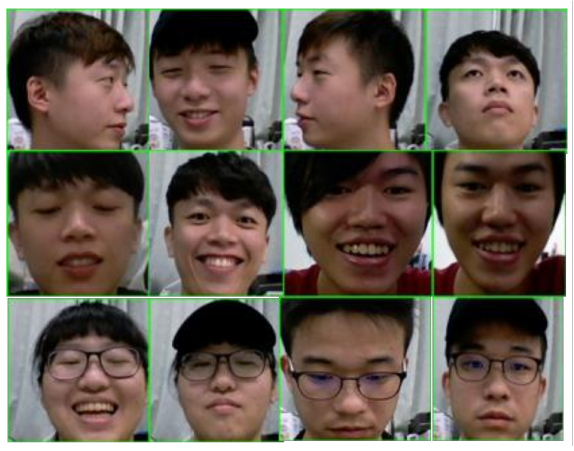
Figure 15. Example of falsely accepted face images.